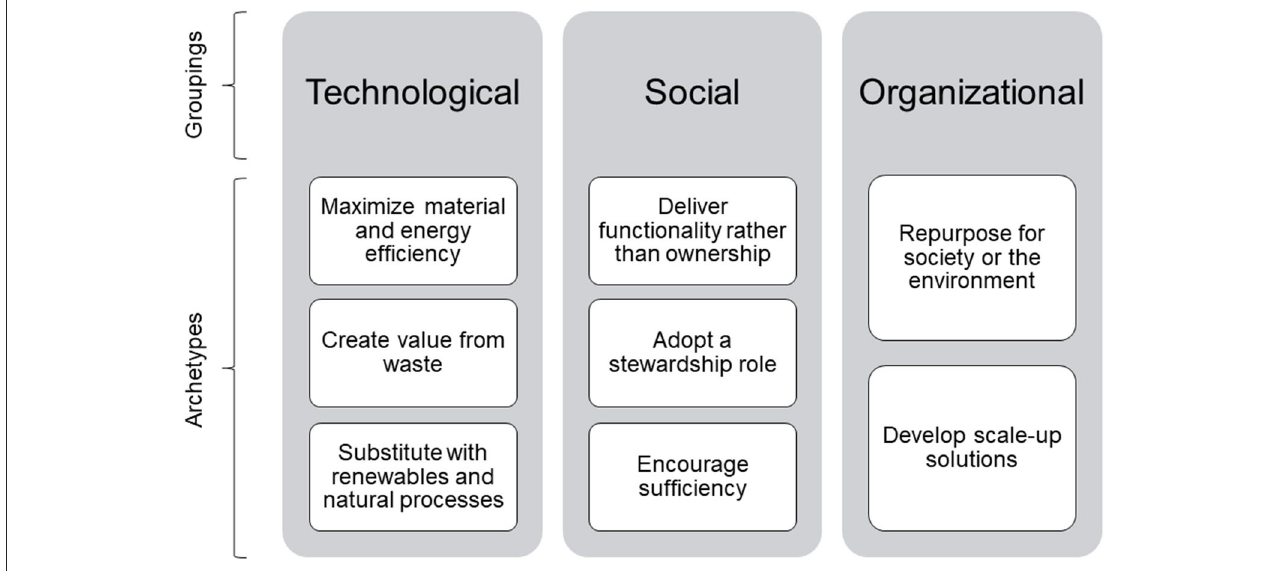
FIGURE1 Sustainable business model archetypes adapted from Bocken et al.